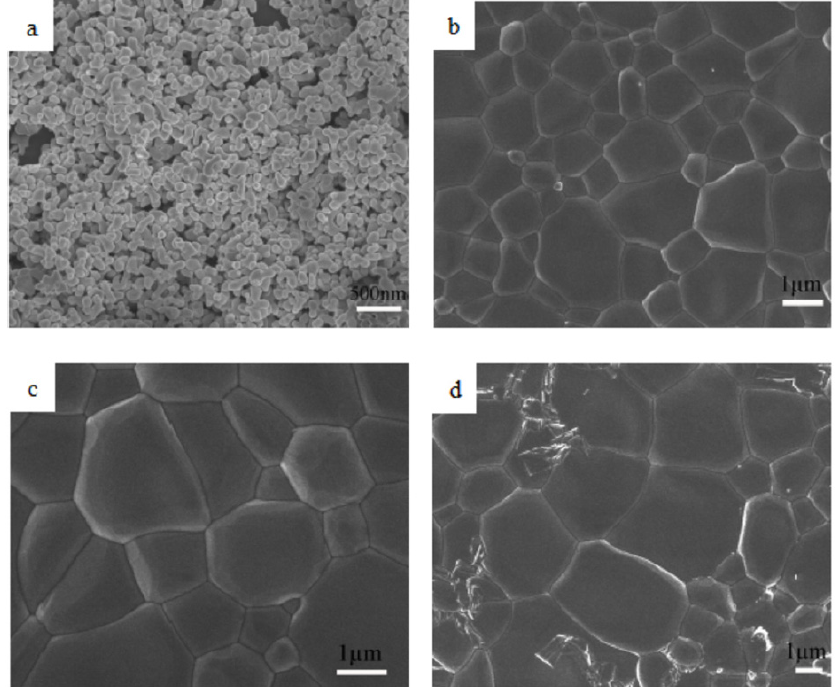
Figure 6. SEM morphology of TGG powders sintered at 1100 ◦ C ( a ), the surface of sample #1 sintered at 1500 ( b ), sample #2 sintered at 1550 ◦ C ( c ), and sample #3 sintered at 1600 ◦ C ( d ) [43]. Reprinted with permission from Ref. [43]. Copyright 2019, copyright ELSEVIER.